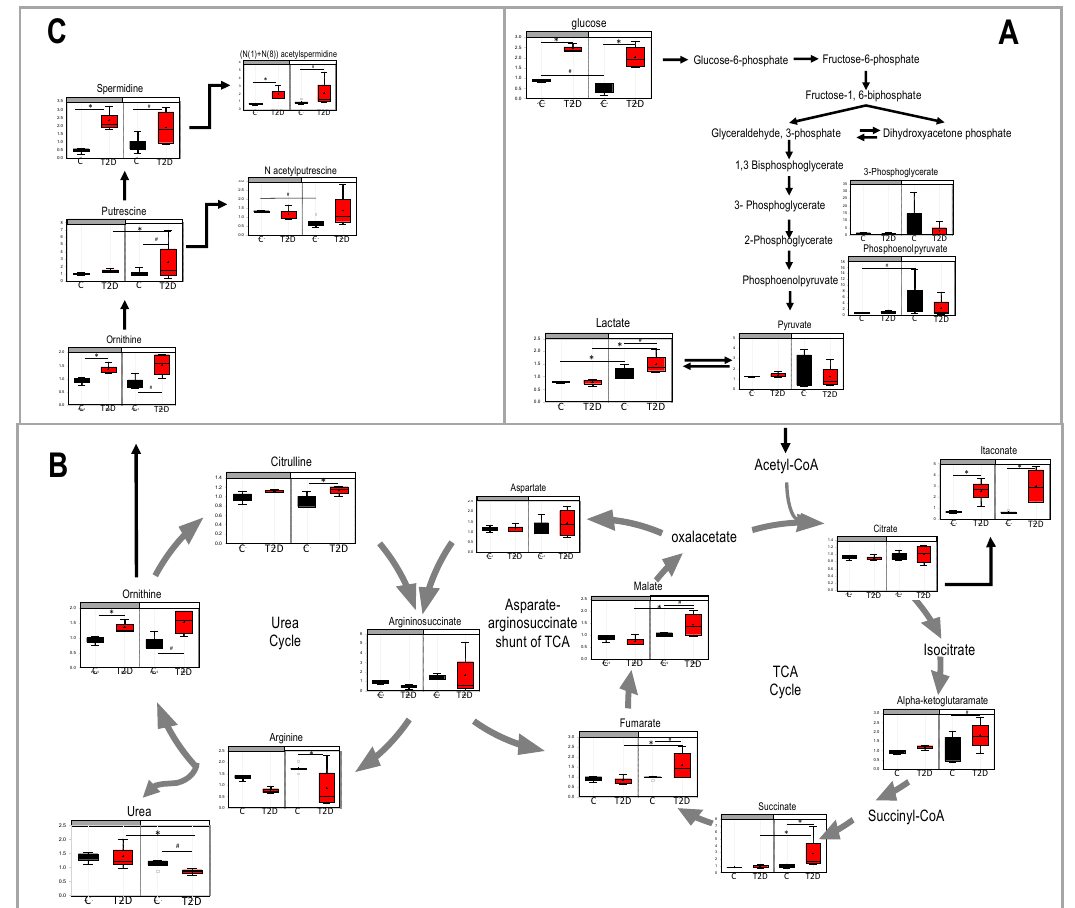
Figure 5. Pathways of metabolites that showed up in the cluster that lost diurnal patterns in type 2 diabetes (T2D). Blood samples were collected at day time (ZT5) and at night time (ZT17) from 10-month-old db/db (red) and aged-matched db/m (black) mice. Untargeted global metabolomics analysis was performed with the Metabolon Platform (Metabolon Inc). ( A ) Glycolysis, ( B ) TCA cycle and urea cycle, and ( C ) polyamine metabolism. n = 3 per time point per group. Two-way ANOVA. (*) indicate statistical di ff erence p < 0.05, and (#) p < 0.01 in post-hoc comparisons. y-axis shows the volume and median = 1 normalized values of area under the curve values form each metabolite. Bars above each chart (grey vs. white) indicate night vs.